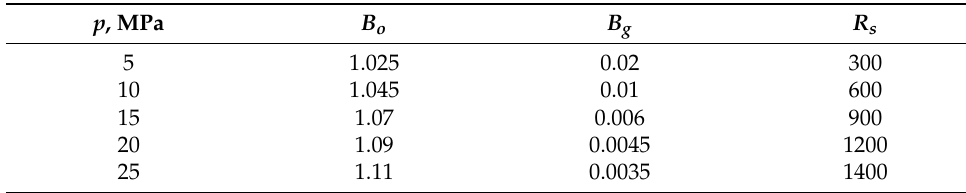
Table 1. PVT property data.